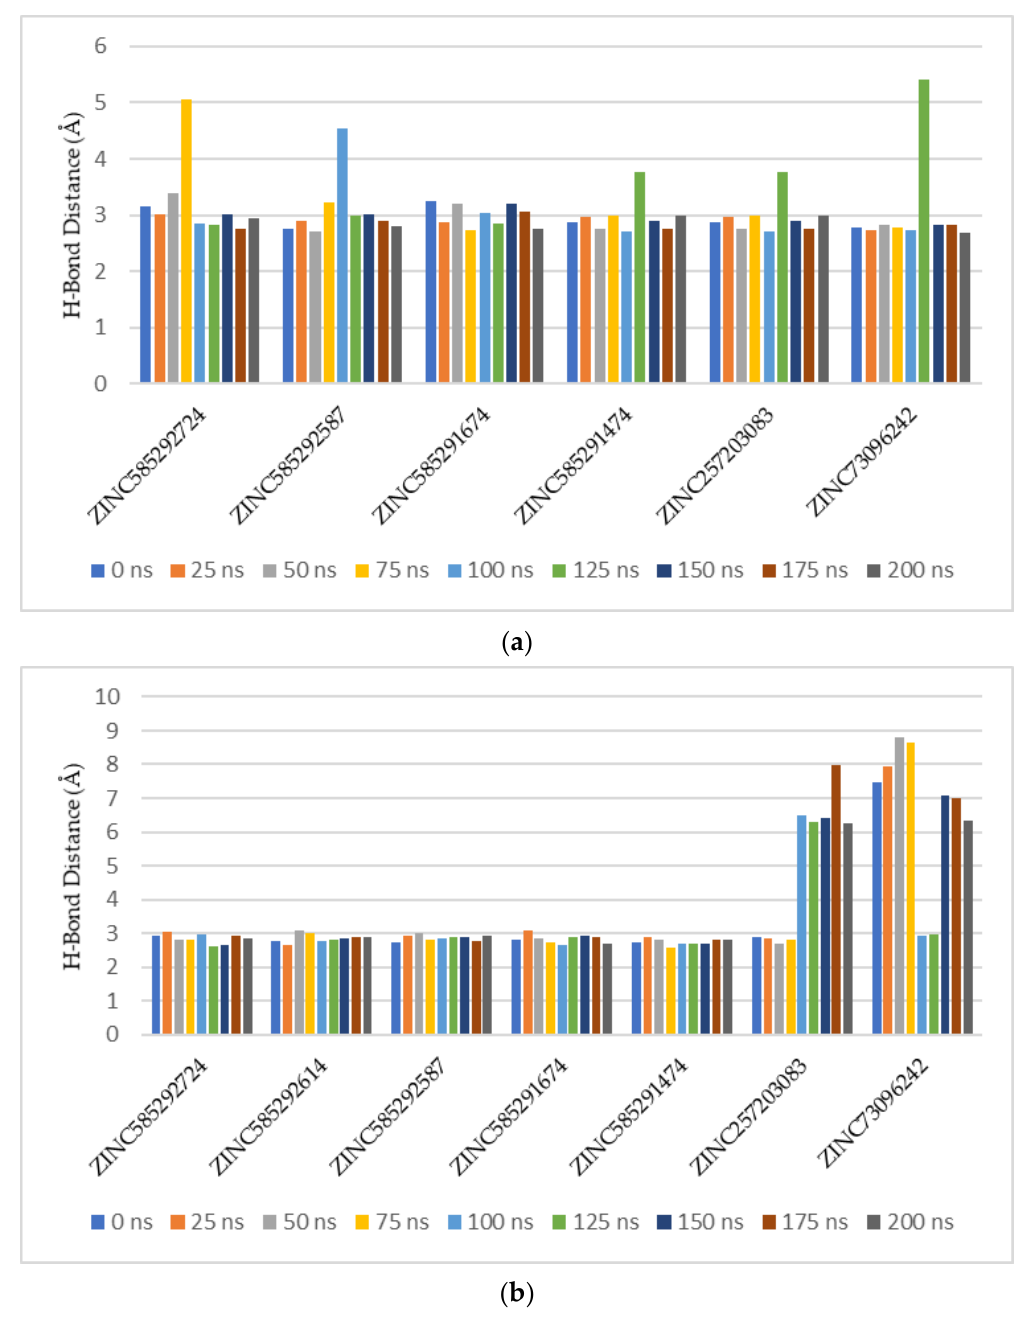
Figure 10. Comparison of the hydrogen bond distances between compounds with Val69 of CDK4 ( a ) and Val101 of CDK6 ( b ) residues during the simulation.